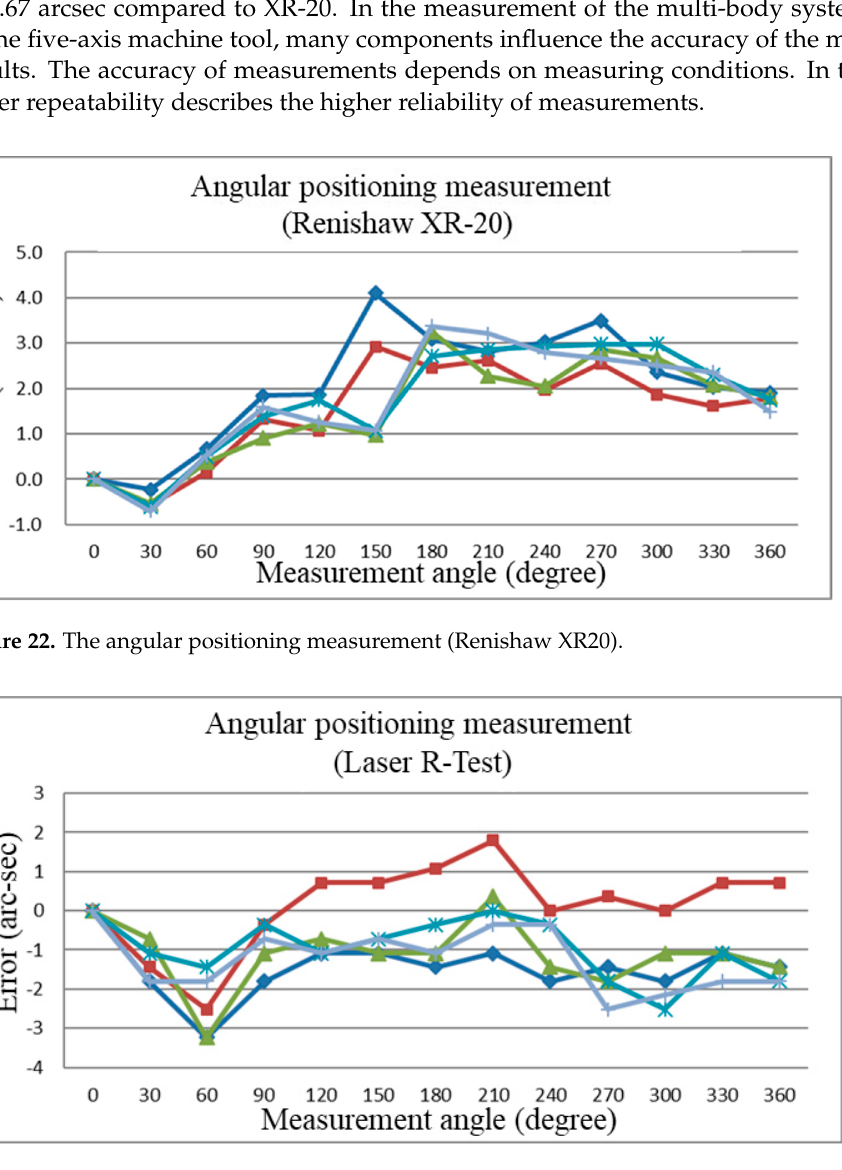
Figure 24. Residual error of Laser R-test.